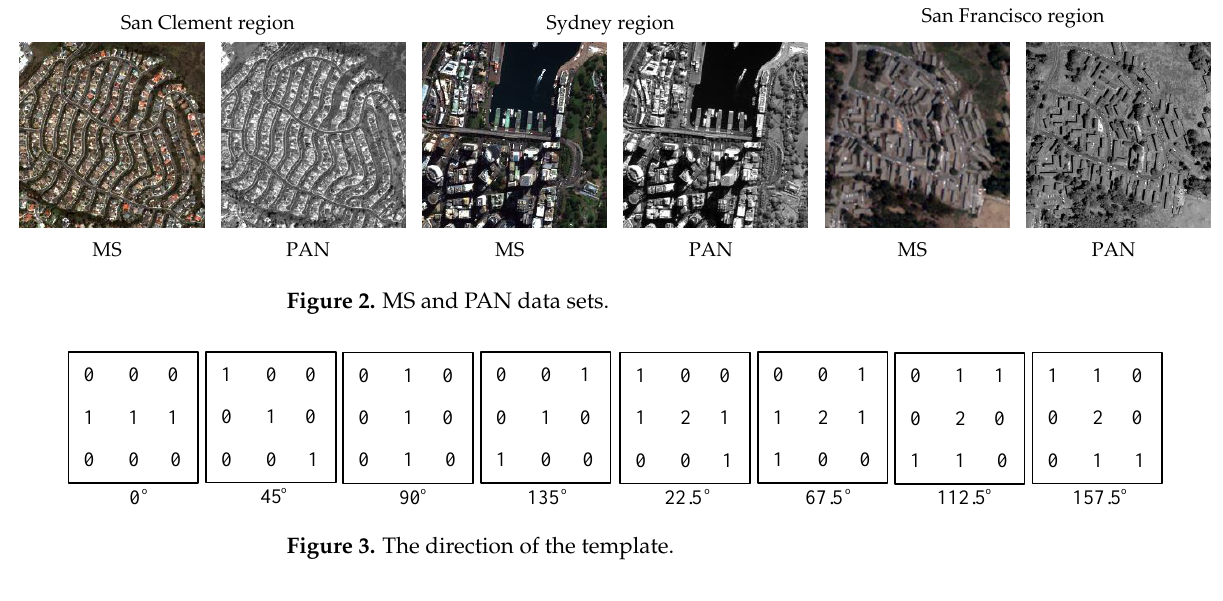
Figure 1. The sub-bands obtained by MS and PAN image after 2 layers decomposition by NSST. ( a ) Original image. ( b ) Low frequency sub-band. ( c ) High frequency sub-band first scale direction one. ( d ) High frequency sub-band first scale direction two. ( e ) High frequency sub-band second scale direction one. ( f ) High frequency sub-band second scale direction two. ( g ) High frequency sub-band second scale direction three. ( h ) High frequency sub-band second scale direction four.